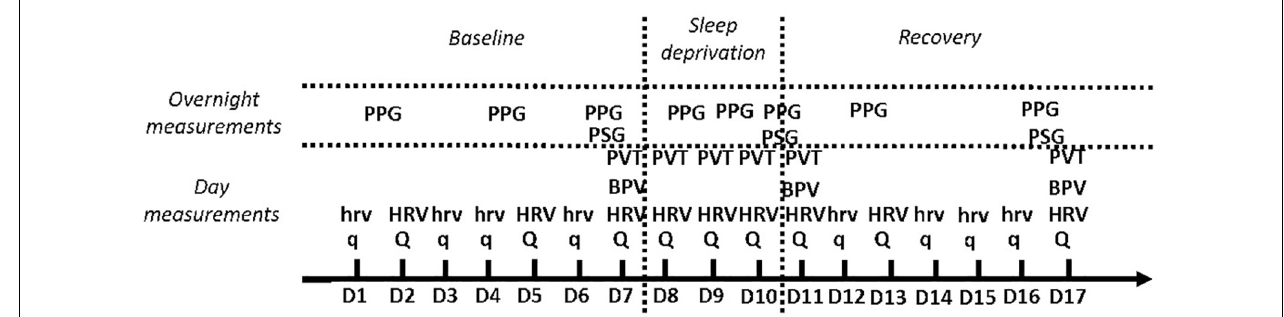
FIGURE 1 | Illustration of the study protocol. q: Eight-item overtraining, Karolinska Sleepiness Scale Groningen Sleep Quality Scale questionnaires. Q: 14-item fatigue scale and Profile of Mood States questionnaires in addition to q. hrv: 3 min in supine position followed by 3 min in standing position orthostatic test. HRV: 6 min supine followed by 6 min standing orthostatic test. BPV, blood pressure variability; PVT, psychomotor vigilance task; PSG, polysomnography; PPG,